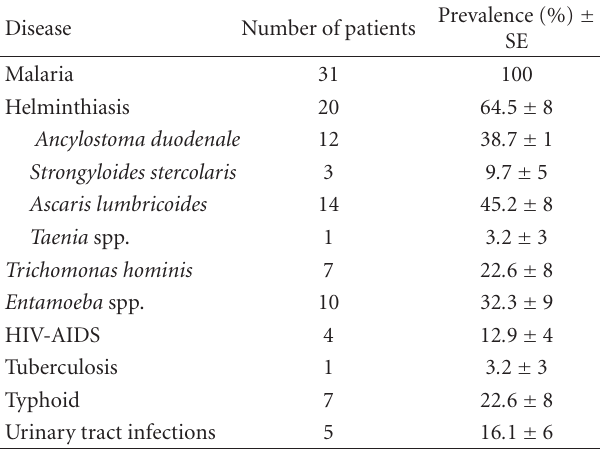
Table 1: Prevalence of coinfections in HAT patients (31) in NSSRH, Alupe, Kenya, from 2000 to